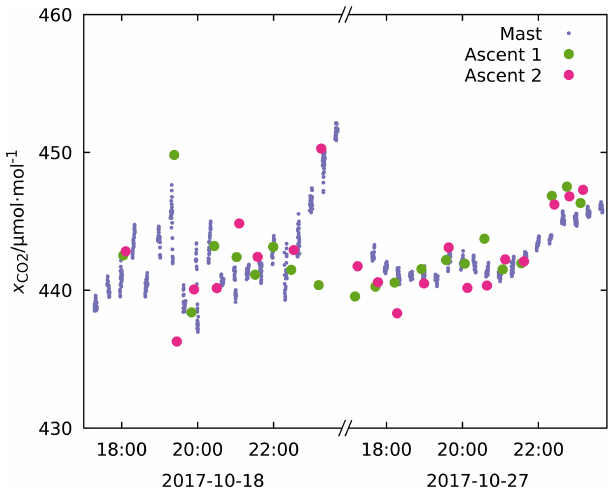
Figure 12. Large dots represent calibrated measurements taken by COCAP during the ascents at a height of (40 ± 10)m above ground, small dots are measurements from the LIN mast’s 40m inlet. Times are in local time (UTC+2). The sun set at 18:02LT on 18 October and at 17:43LT on 27 October. The gaps in the station data are due to the measurement of other inlets and working tanks at those times.